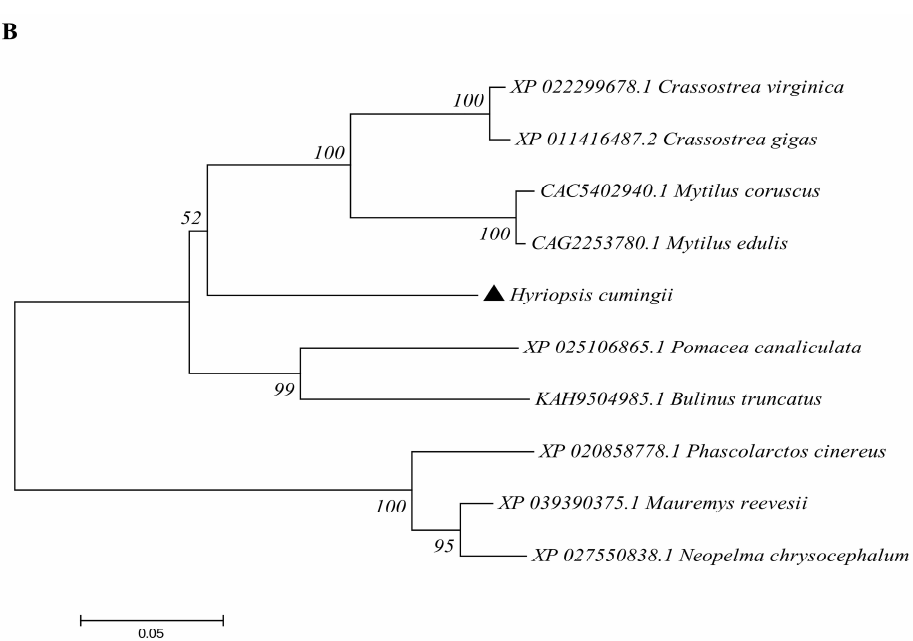
Figure 3. Sequence alignment and phylogenetic tree construction of the MK2 amino acid sequences in H. cumingii with other species. ( A ) Multiple alignment analysis of the MK2 amino acid sequences of H. cumingii with those in other species. The MK2 amino acids of the selected species are enumerated. The black parts are amino acid residues conserved and the gray parts are similar to amino acid residues in different species. ( B ) NJ Phylogenetic tree of MK2 protein of H. cumingii and other creatures. The phylogenetic tree was constructed and inferred by maximum likelihood analysis using MEGA7.0. The numbers are the bootstrap test confidence values with 1000 bootstrap repeats.